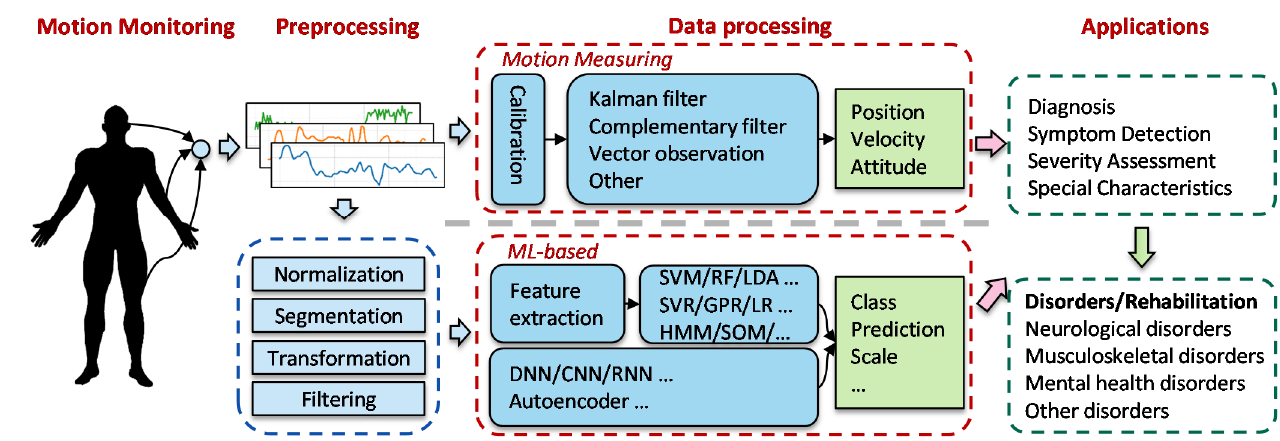
Figure 1. Generalized workflow for monitoring human body motions.